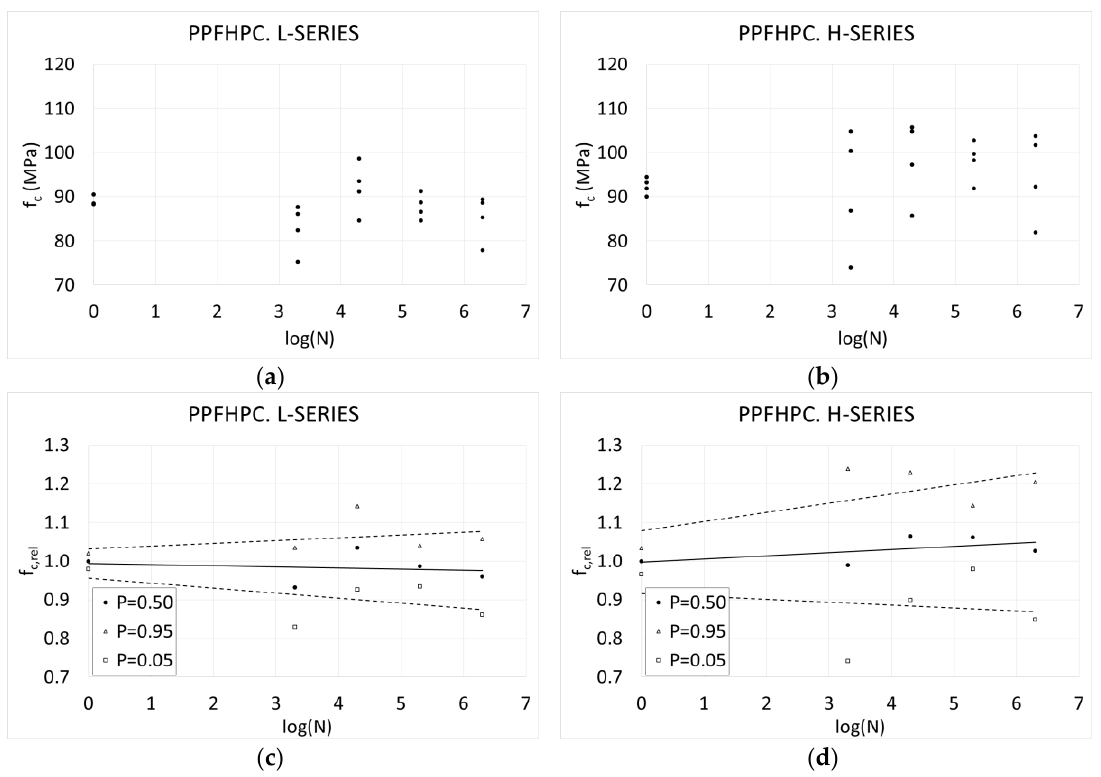
Figure 6. Variation of compressive strength by number of cycles. PPFHPC ( a ) L-Series. Raw values. ( b ) H-Series. Raw values. ( c ) L-Series. Maximum, minimum, and average relative values, and tendency lines. ( d ) H-Series. Maximum, minimum, and average relative values, and tendency lines.